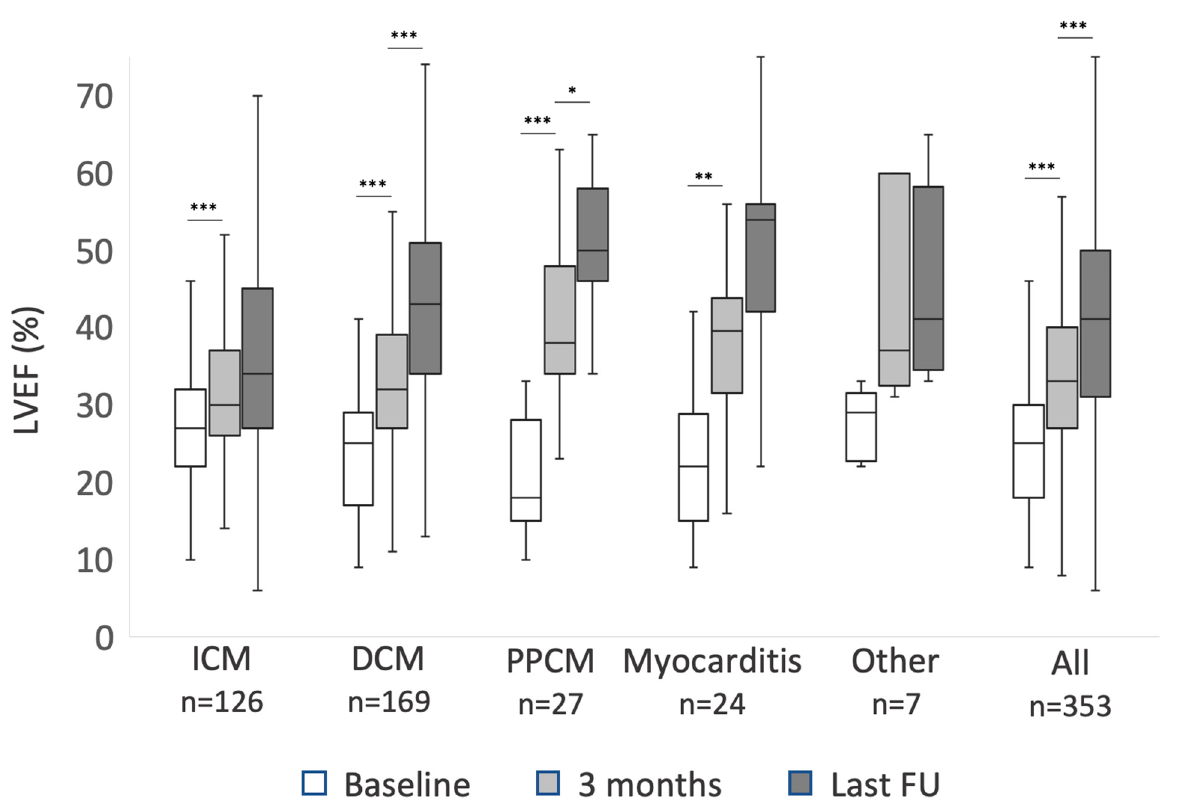
Figure 1. The improvement of left ventricular ejection fraction (LVEF) during follow-up of patients with newly diagnosed heart failure with reduced ejection fraction (HFrEF): mean values at baseline, three months, and last available follow-up (FU) for patients with ischemic cardiomyopathy (ICM), dilated cardiomyopathy (DCM), peripartum cardiomyopathy (PPCM), myocarditis and other diagno- sis. Asterisks mark p -values < 0.05 (*), <0.01 (**) and <0.001 (***). Difference between 3 months and last FU LVEF in patients with myocarditis did not meet statistical significance with p =